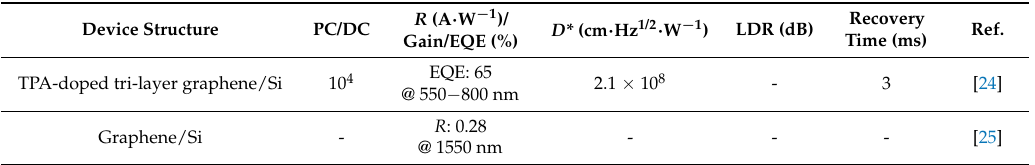
Table 1. Figure-of-merit parameters of semiconductor heterostructure photodetectors with graphene TCEs, reported until